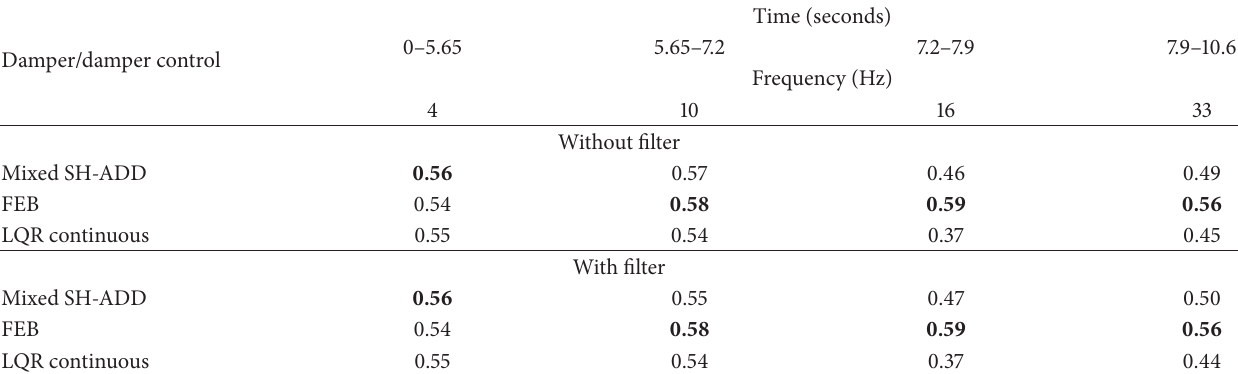
Table 3: BSST, full throttle acceleration improvement index (higher is